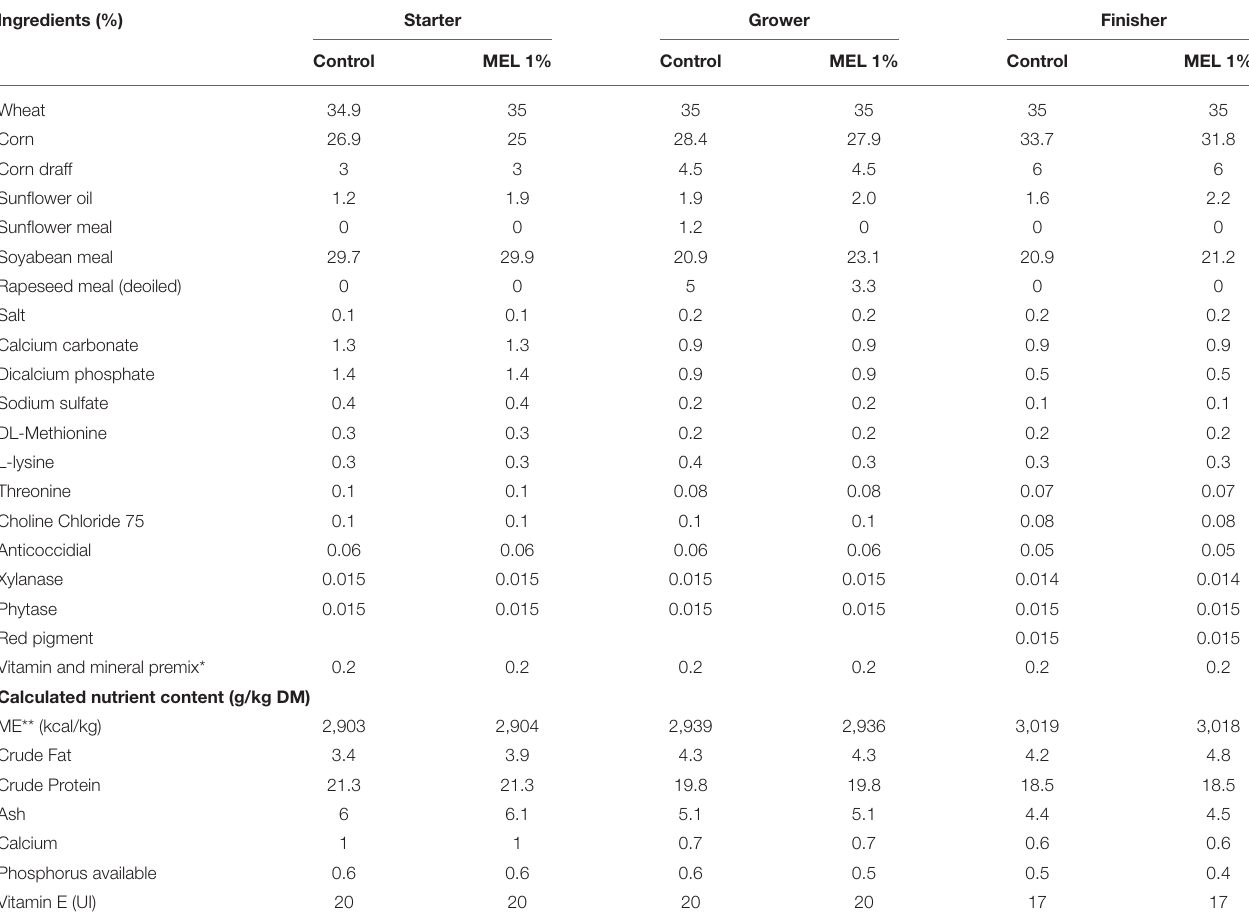
TABLE 3 | Composition of the basal feed of chickens during the suboptimal experiment: starter (D1-11), grower (D12-21) and finisher (D22-31) periods (Design 2). Ingredients (%) Starter Grower Finisher Control MEL